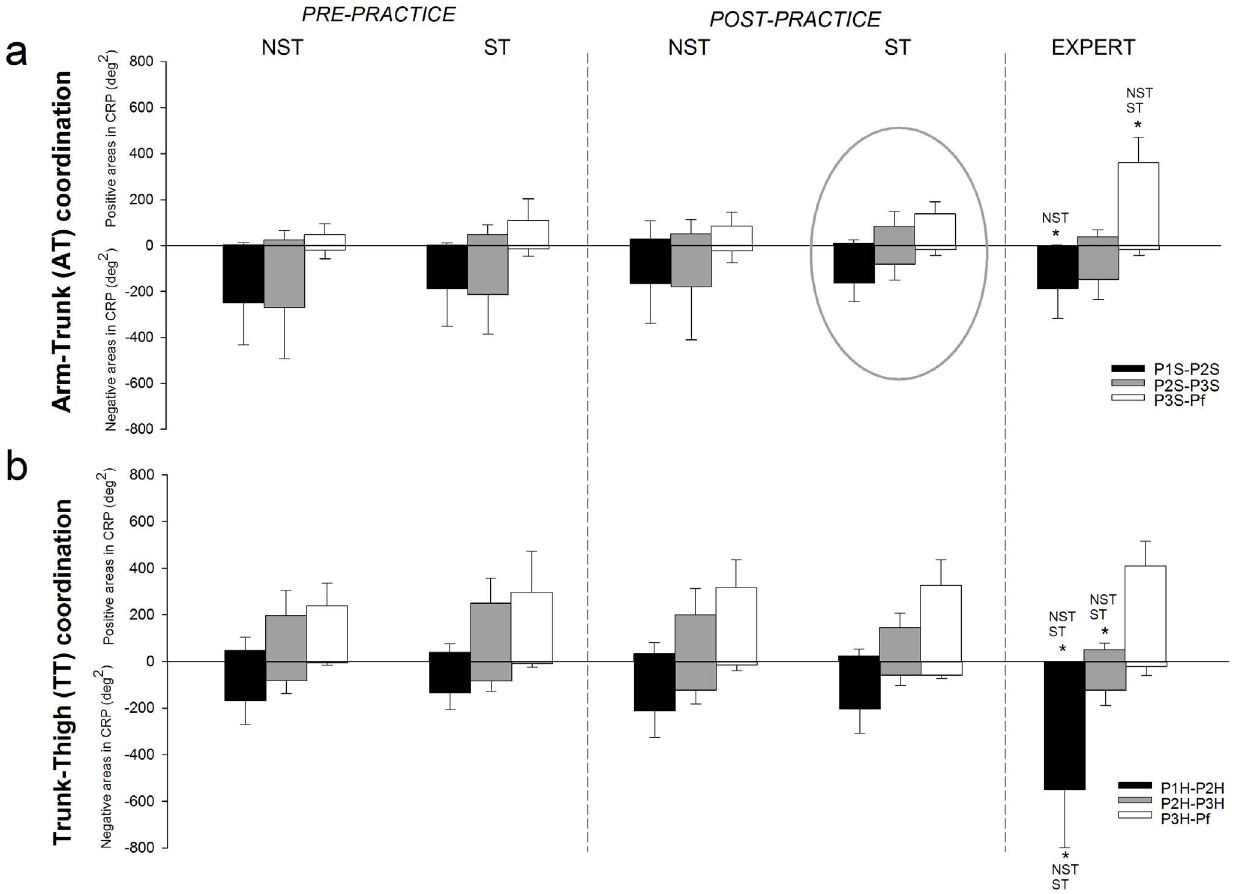
Figure 4. Positive and negative areas in the continuous relative phase for each group. Positive and negative areas’ mean and standard deviation for each group (spontaneously-talented, ST, non-spontaneously-talented, NST, and experts) are depicted in: (a) arm-trunk (AT) coordination and (b) trunk-thigh (TT) coordination. Positive and negative areas are calculated over the interval between events of the same joints: P1S-P2S, P2S- P3S, and P3S-Pf in the AT continuous relative phase; and P1H-P2H, P2H-P3H, and P3H-Pf in the TT continuous relative phase. AT coordination mode for the ST during post-practice is highlighted by a circle in order to emphasize the progression toward the expert coordination mode. ( w ) indicates significant group differences comparing novice (NST and ST) post-practice and